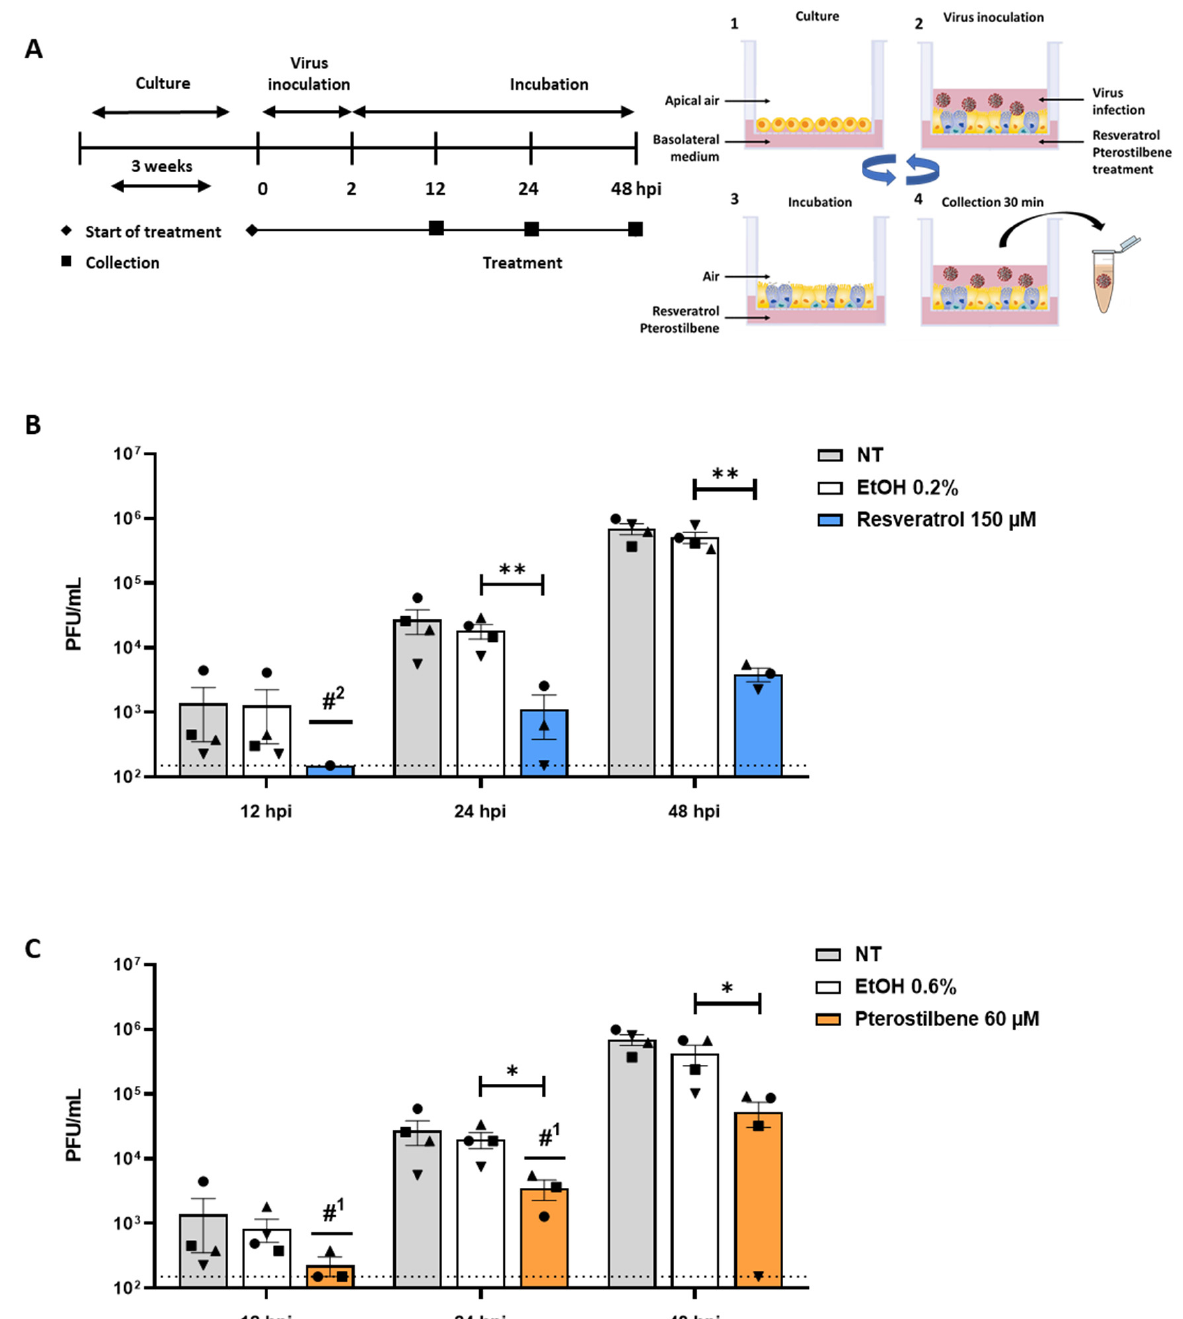
Figure 4. Resveratrol and pterostilbene inhibit SARS-CoV-2 infection in primary human bronchial epithelial cells. ( A ) Schematic representation of the experimental design. ( 1 ) Primary human bronchial epithelial cells (PBECs) were cultured on permeable inserts under Air Liquid Interface (ALI) conditions for 21 days. ( 2 ) Cells were inoculated with SARS-CoV-2 MOI 5 at the apical side. ( 3 ) At 2 hpi, the virus inoculum was removed and cells were exposed to air until virus collection. ( 4 ) Medium was added to the apical side and collected after 30 min incubation. After supernatant collection, PBECs were exposed to air again (3) until the next collection time point. Steps 4 and 3 were repeated until the end of the experiment. ( B , C ) Virus particle production in PBECs in presence of (B) resveratrol or (C) pterostilbene. Scheme adapted from STEM- CELL Technologies. Data are represented as mean ± SEM, symbols represent three or four different donors. Dotted line indicates the threshold of detection. The number of values below detection limit are indicated with # X . Student T test was used to evaluate statistical differences and a p value ≤ 0.05 was considered significant with * p ≤ 0.05, ** p ≤ 0.01. In the absence of ‘*’ the data is non-significant.